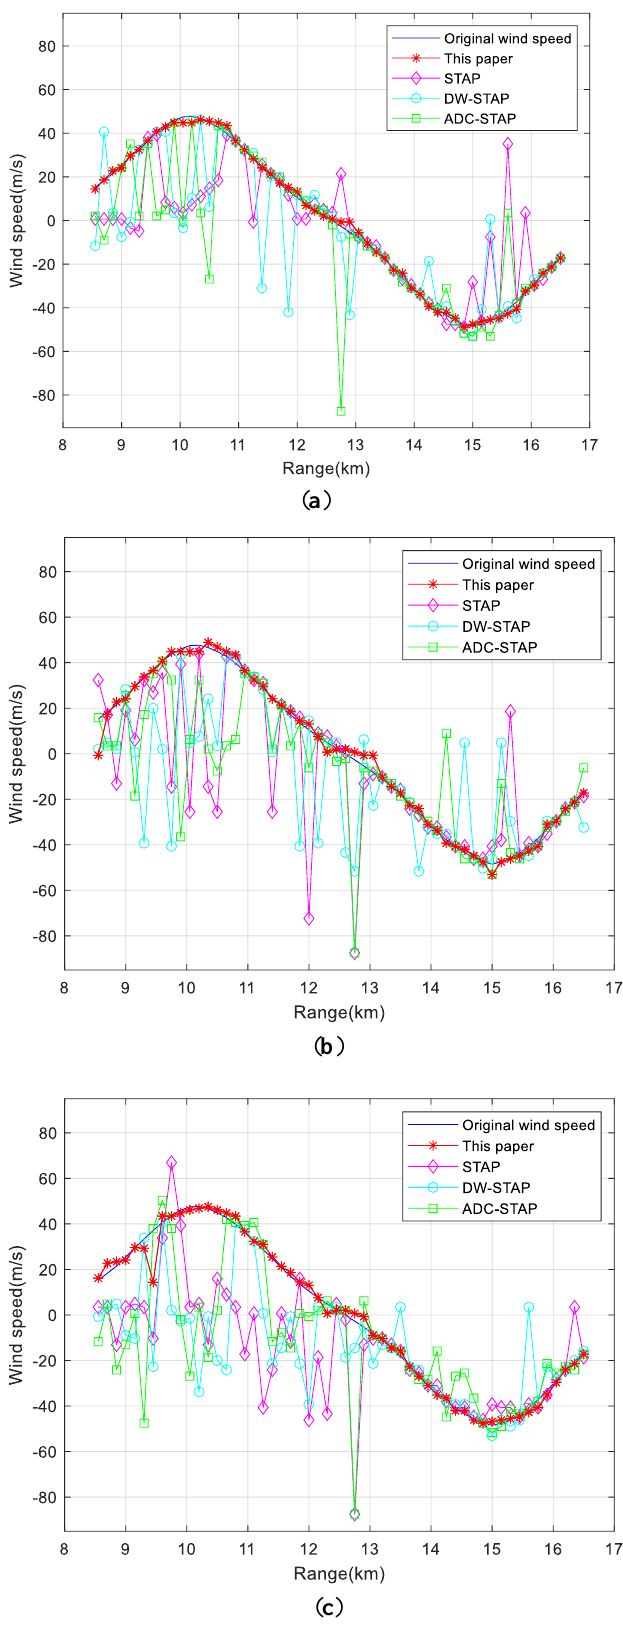
Figure 7. Comparison of the wind speed estimation results under different CNR conditions. ( a ) 40 dB ( b ) 50 dB ( c ) 60 dB